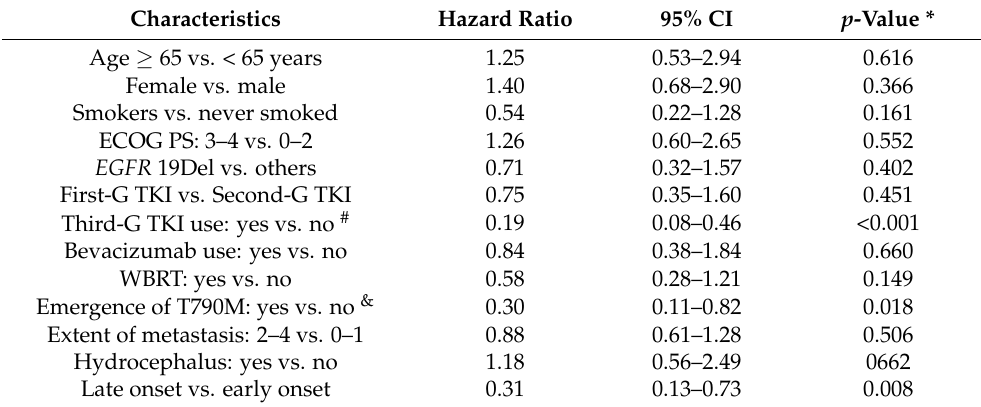
Table 3. Univariate analysis of the overall survival among EGFR -mutant patients with leptomeningeal metastasis.